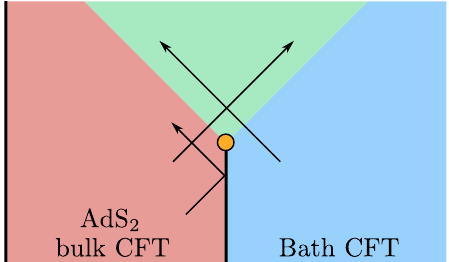
Figure 1 . Our two-sided AdS 2 system initially has re(cid:13)ecting boundary conditions (solid vertical lines) on its right boundary. An independent copy B of our CFT on the right half of Minkowski space which will play the role of the bath also begins with re(cid:13)ecting boundary conditions. At some (cid:12)nite time (orange dot), the right-AdS 2 boundary conditions become transparent, coupling the AdS 2 CFT to the Bath